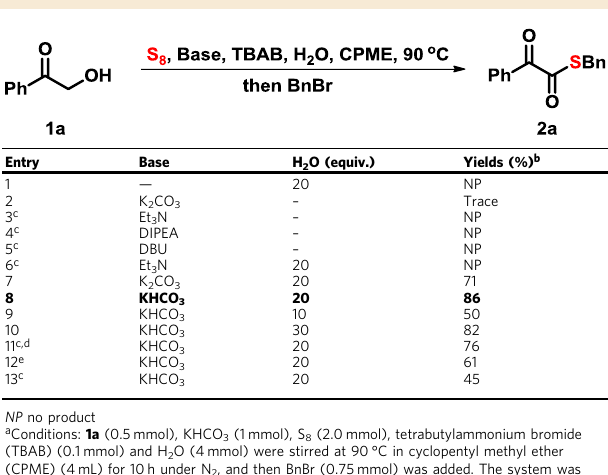
Table 1 Optimization of the 1,2-dicarbonyl-forming reagent